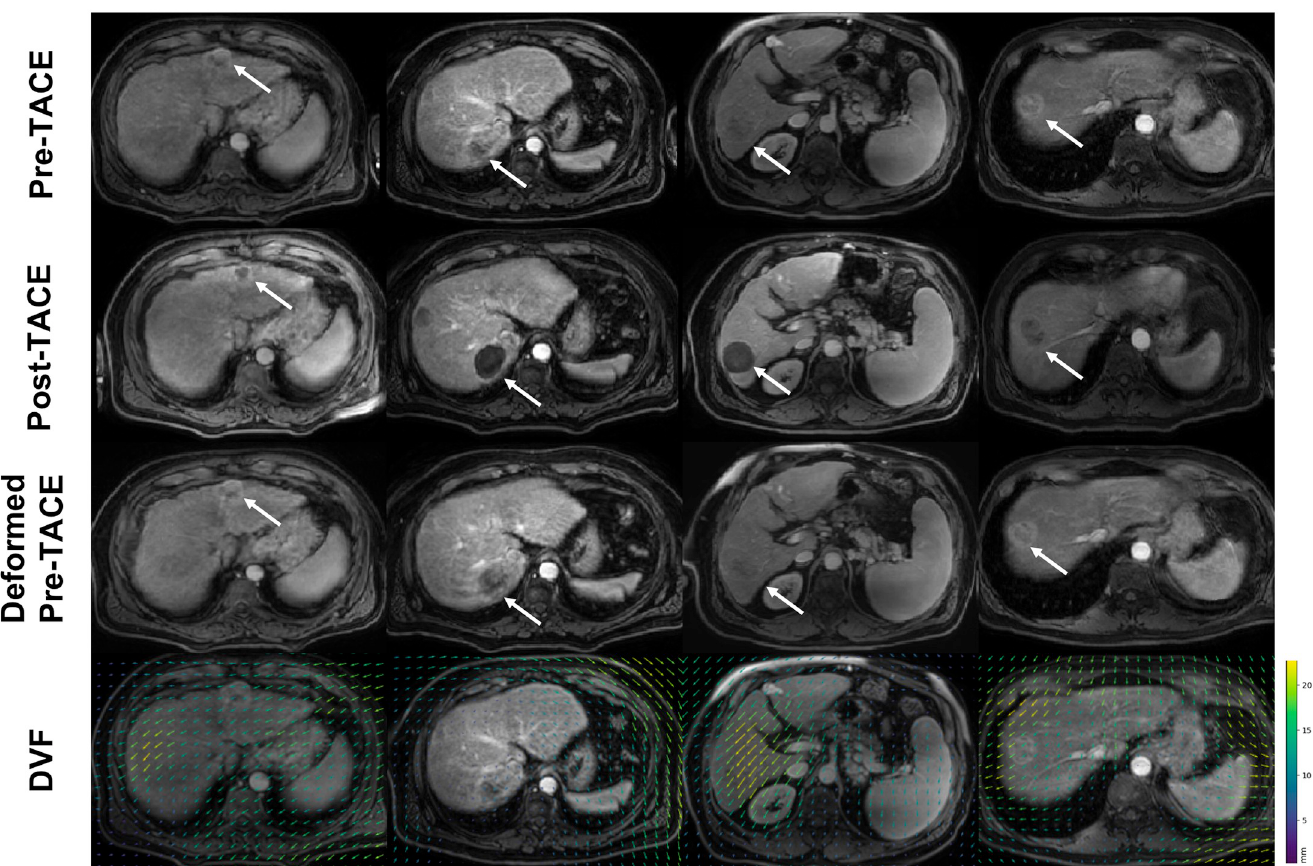
Fig 6. Illustration of deformable registration results on 4 DCE-MRI cases (columns), achieving the non-rigid alignment of pre-TACE to post-TACE DCE-MRI examinations used for training purposes. The last row illustrates the deformation vector fields (DVF) obtained on the coronal slices.